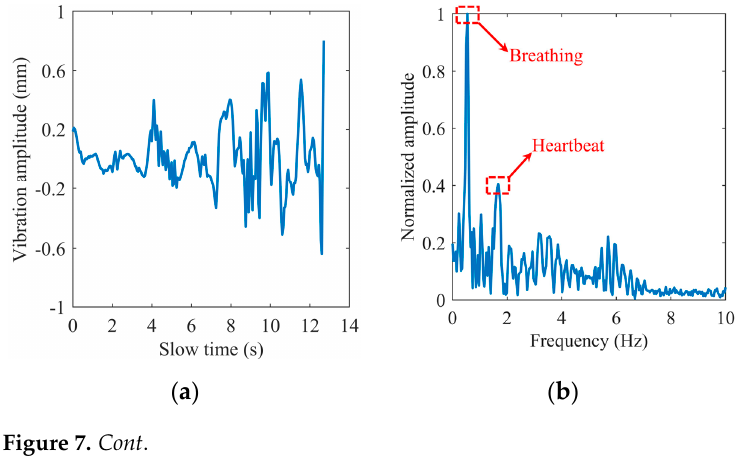
Figure 7. The impulse noise removal: ( a ) in the time domain; ( b ) in the frequency domain; ( c ) wave- form comparison before and after denoising. 2.2.5. Vital Signs Detection The respiration rate is obtained by extracting its spectral peak value through the FFT- CZT hybrid algorithm. The algorithm mainly refers to our previous work [14], and refines the spectrum based on FFT to obtain more accurate local spectrum information. Since the amplitude of chest vibration caused by breathing is much larger than that caused by the heartbeat, the extraction of the heartbeat signal is more complex. The following are the specific steps. (1) Filter out the respiratory signal through a band-pass filter: Considering the general heart-rate range, we select an elliptical band-pass filter with a passband of 0.7–3.3 Hz. The finite transmission zeros in the stopband of the elliptic filter reduce the transition region, and then an extremely steep attenuation curve can be obtained. Thus, it has a very narrow transition bandwidth;